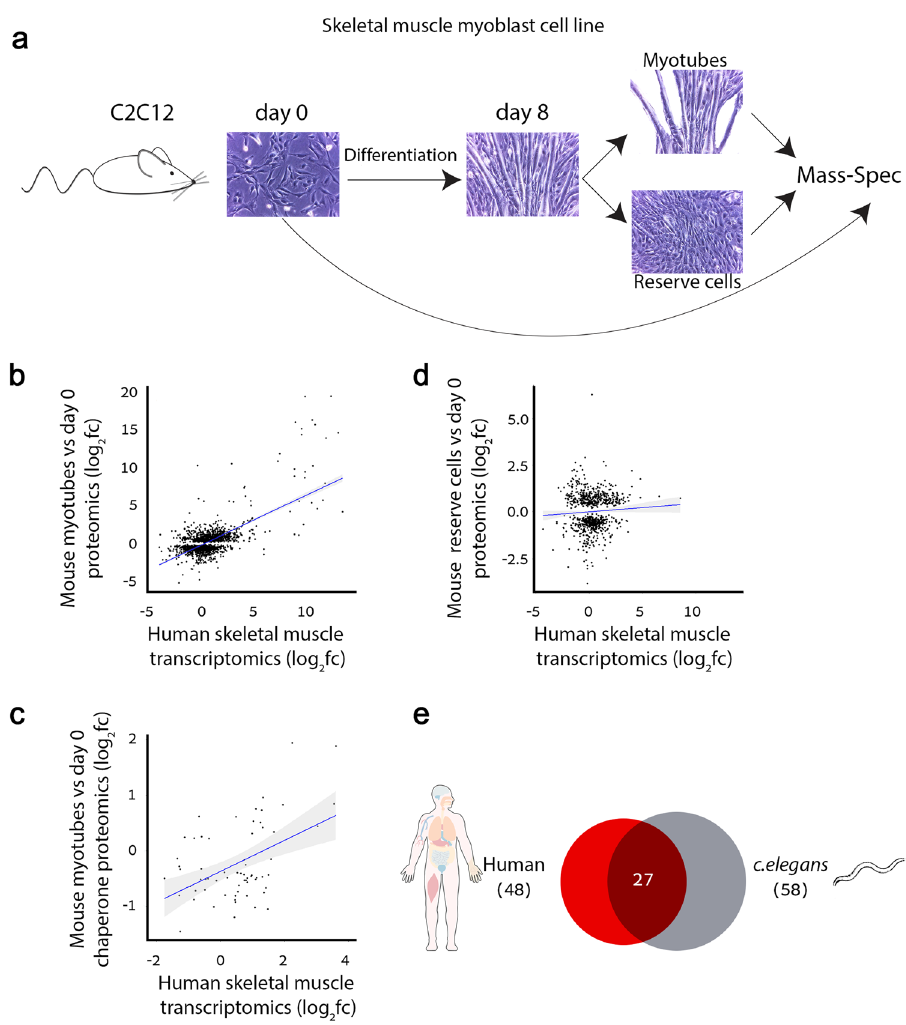
Fig. 3 Chaperone expression in muscle tissue is evolutionary conserved. a The experimental pipeline. C2C12 mouse myoblast cell line was grown to 95% con fl uency and differentiation was induced. After 8 days of differentiation, cells were separated to myotubes and reserve (undifferentiated) cells, and their proteomes were analyzed using mass spectrometry (three biological replicates for each treatment were used). b The correlation between the differential protein levels of 1561 proteins that were reliably measured in mouse myotubes vs. undifferentiated C2C12 cells, and the differential expression of their homologous genes in human skeletal muscle ( r = 0.65, p = 2.2E − 16, Pearson correlation). c The correlation between the differential protein levels of 65 chaperones that were reliably measured in mouse myotubes versus undifferentiated C2C12 cells, and the differential expression of their homologous genes in human skeletal muscle ( r = 0.47, p = 7.8E − 5, Pearson correlation). d The differential protein levels of 754 proteins that were reliably measured in mouse reserve cells versus undifferentiated cells do not correlate with the differential expression of their homologous genes in human skeletal muscle ( r = 0.06, Pearson correlation). e The overlap between 58 C. elegans muscle chaperones and 48 homologous chaperones that were up-regulated (log 2 fc ≥ 1) in human skeletal muscle ( p = 0.0009, one-sided Fisher exact test). The 157 human chaperones with homologous genes in C. elegans were considered in the analysis. Source data are provided as a Source Data fi